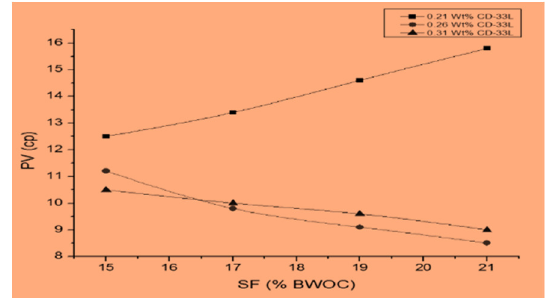
FIG. 2. EFFECTS OF SF AND DISPERSANT ON PV OF 13 PPG SLURRY The PV of cement slurries was determined using FIG. 3. EFFECTS OF SF AND DISPERSANT ON YP OF 13 PPG HPHT viscometer. Fig. 2 depicts that 0.21 %Wt SLURRY concentration of dispersant the PV of cement slurries was increasing by increasing the concentration of The YP of cement slurry is very important property of silica fume. The PVs of slurries increased from 12.5- slurry. The measurement of YP is important